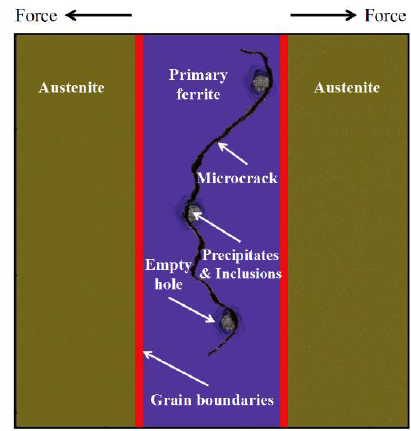
Figure 12. Schematic diagram of the microcrack formation mechanism.